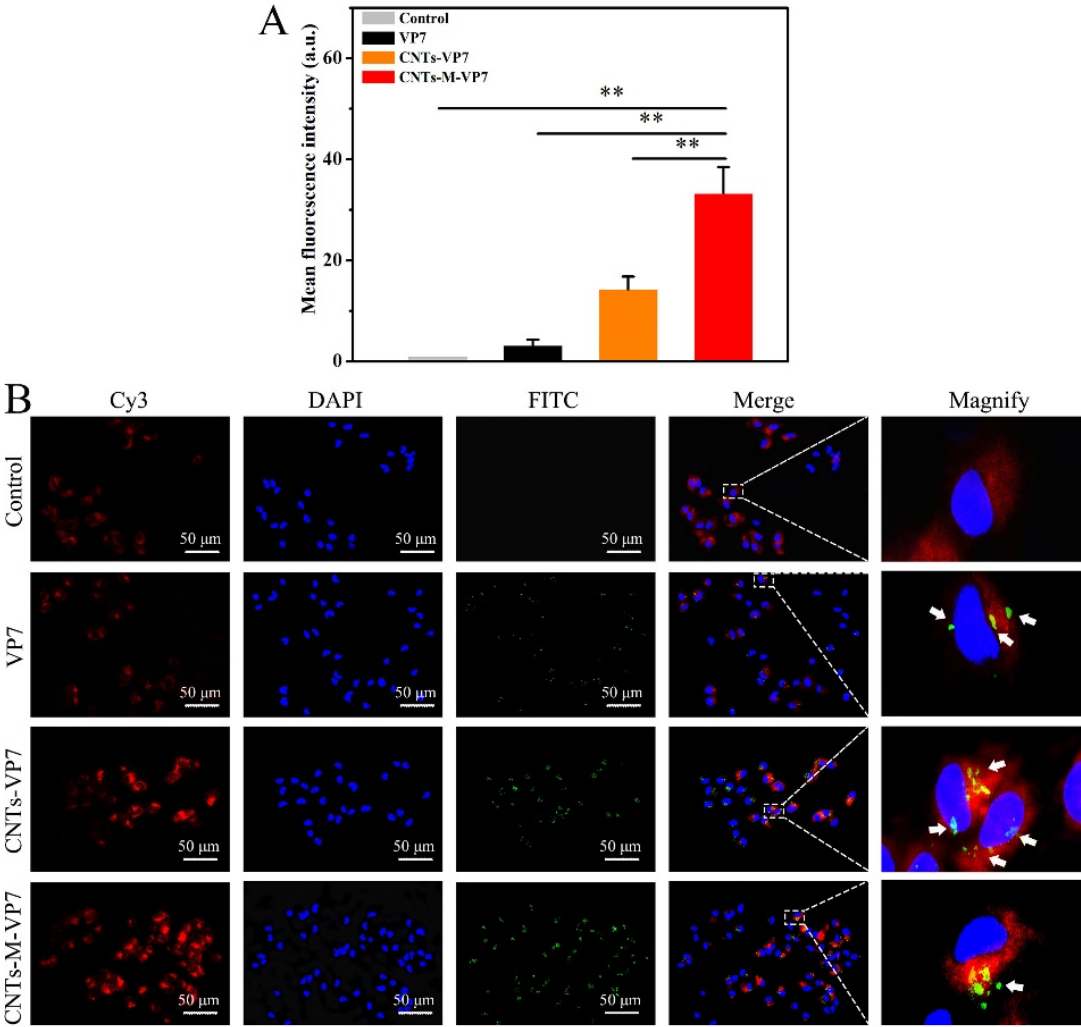
Figure 2. Cellular uptake of nanovaccine by macrophage in vitro. ( A ) Mean fluorescence intensity of cell uptake capability. Data are presented as the mean ± SD. p values were calculated by Student’s t -test (** p < 0.01, * p < 0.05). ( B ) Representative confocal microscopic images of macrophage incubated with VP7, CNTs-VP7, and CNTs-M-VP7, respectively. The unhandled macrophages served as the control. Vaccines were labeled with FITC (green channel), respectively; The cell nucleus was labeled with DAPI (blue channel); The mannose receptor was labeled with Cy3 (red channel).